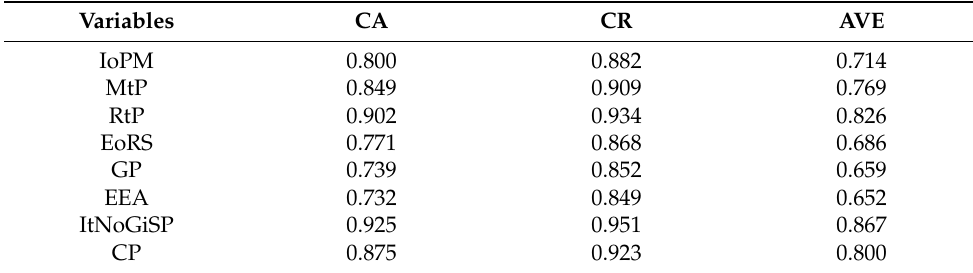
Table 4. Results of reliability and validity tests.